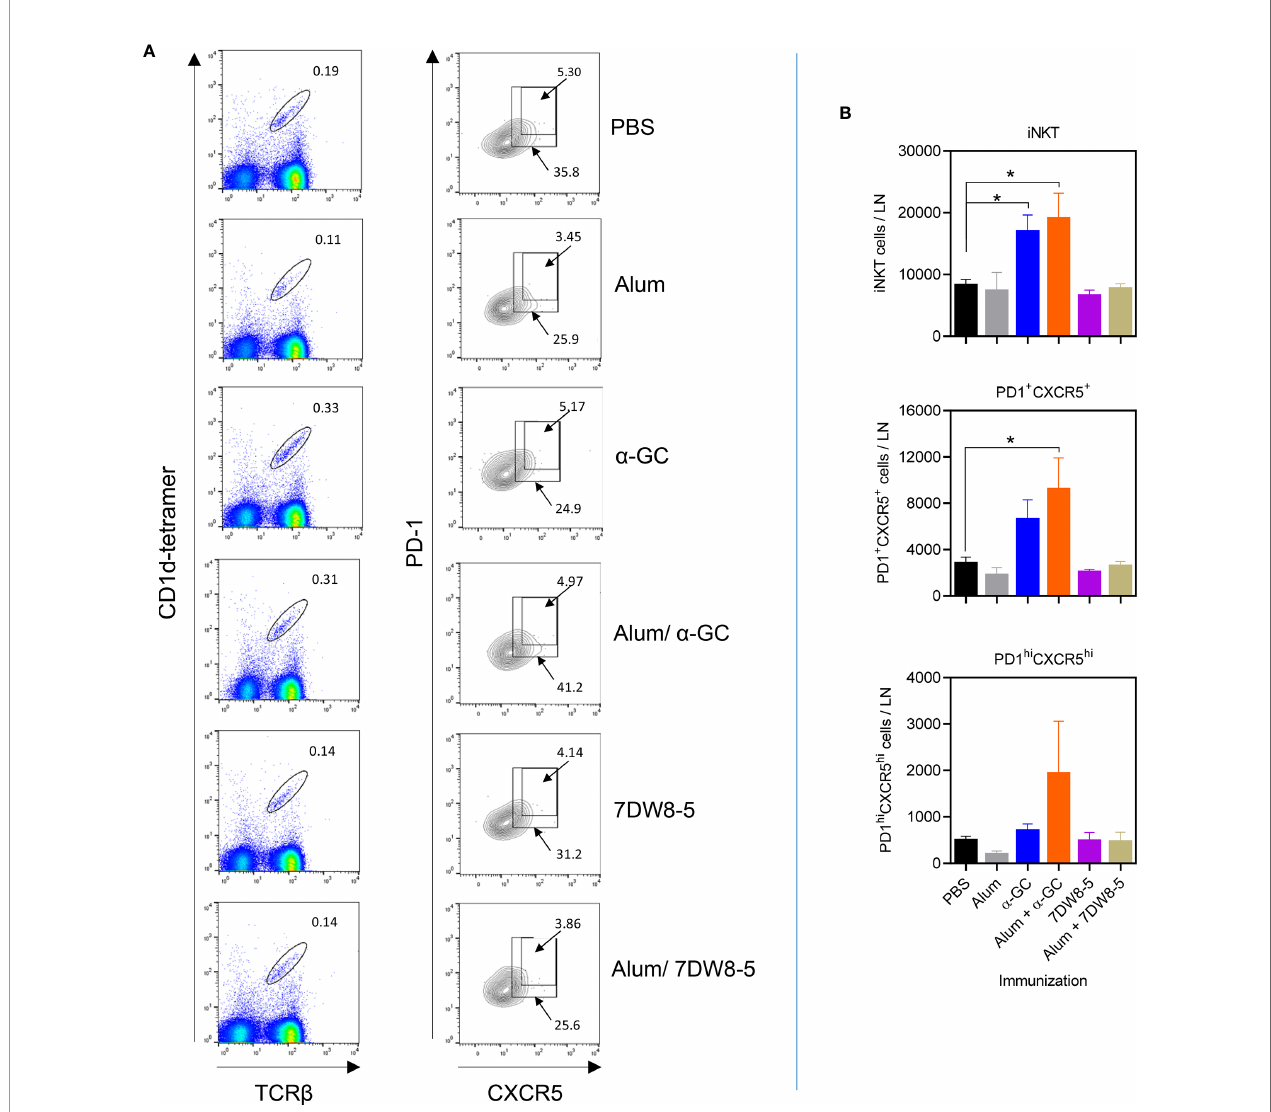
FIGURE 4 | Expansion of iNKTfh cells following administration of single and combination adjuvants. Lymph nodes from mice described in this fi gure were analyzed by fl ow cytometry for iNKTfh cells. (A) Shows representative fl ow cytometry plots of CXCR5 + /PD-1 + and CXCR5 hi /PD-1 hi events after gating on TCR b + /tetramer + events. (B) Graphs show mean ± SEM absolute numbers of TCR b + /tetramer + , CXCR5 + /PD-1 + and CXCR5 hi /PD-1 hi events. Data shown 2 pooled experiments with similar results (PBS, Alum n=6, a -GC, Alum/ a -GC n=6, 7DW8-5, Alum/7DW8-5 n=3). One way ANOVA with Dunnett ’ s post-test was used to detect signi fi cant differences (*p <